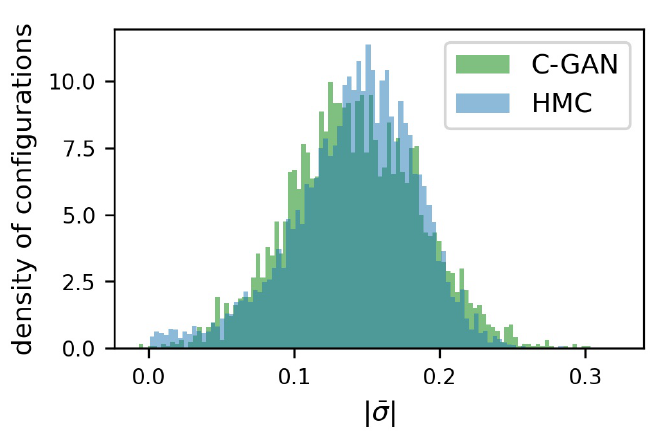
: HMC and C-GAN histograms overlaps ts